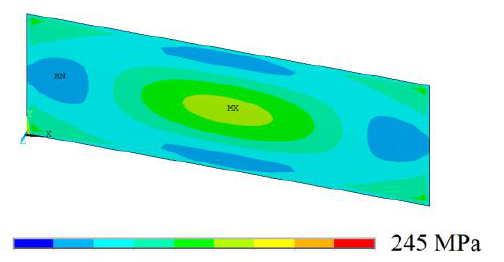
Figure 6. The von Mises stress distribution for the rectangular plate with no hole.